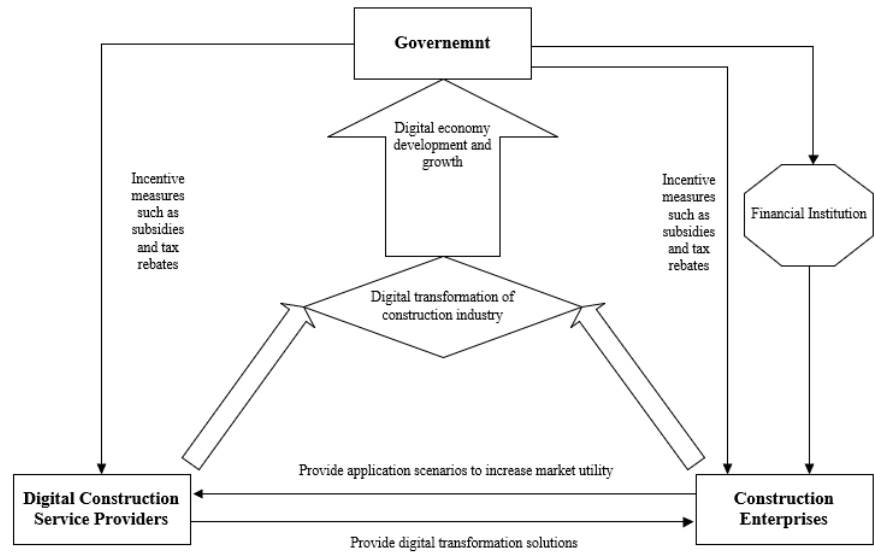
Figure 1. Game model of construction enterprises, service providers, and government.